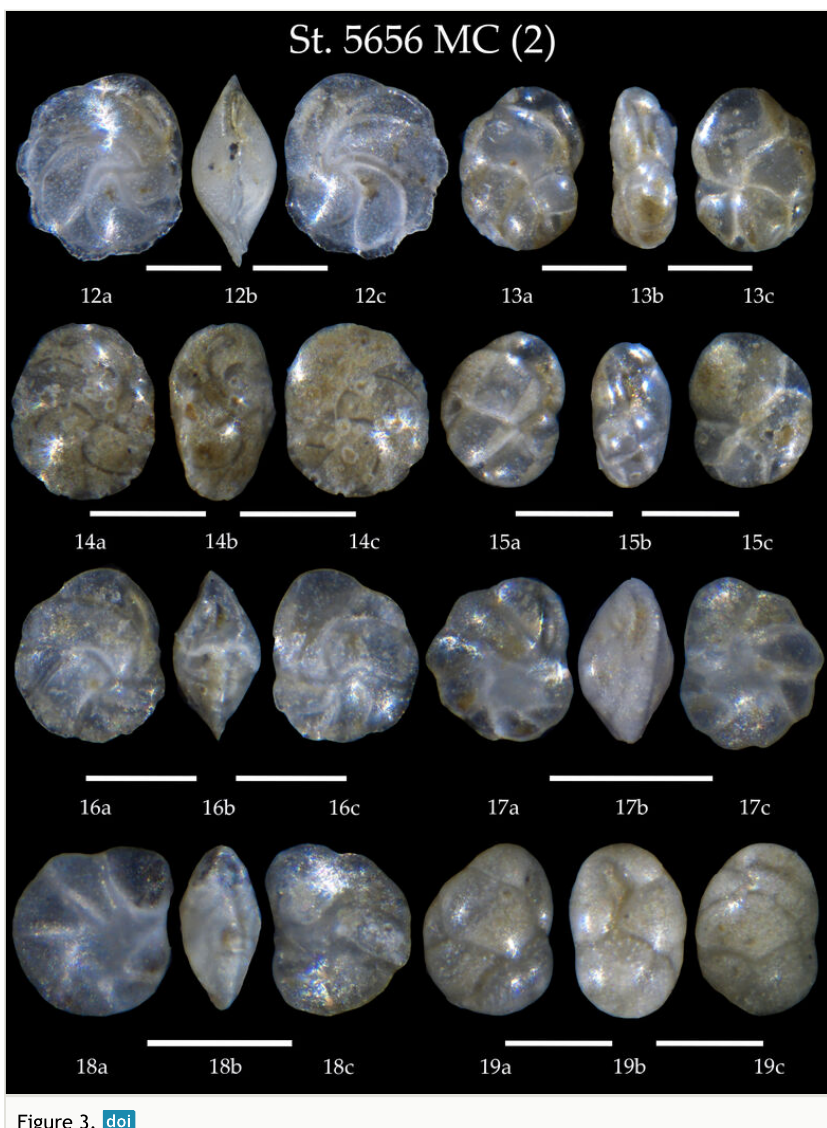
Figure 3. Station 5656 MC (continued). 12 Cassidulina carinata , a, b apertural view, c lateral view; 13 Cassidulina obtusa , a, b apertural view, c lateral view; 14 Cassidulina laevigata , a, b apertural view, c lateral view; 15 Cassidulina reniforme , a, b apertural view, c lateral view; 16 Cassidulina sp., cf. C. laevigata , a, b apertural view, c lateral view; 17 Cassidulina teretis , a, b apertural view, c lateral view; 18 Islandiella norcrossi , a, b apertural view, c lateral view; 19 Globocassidulina subglobosa , a side view, b apertural view, c lateral view. Scale 100